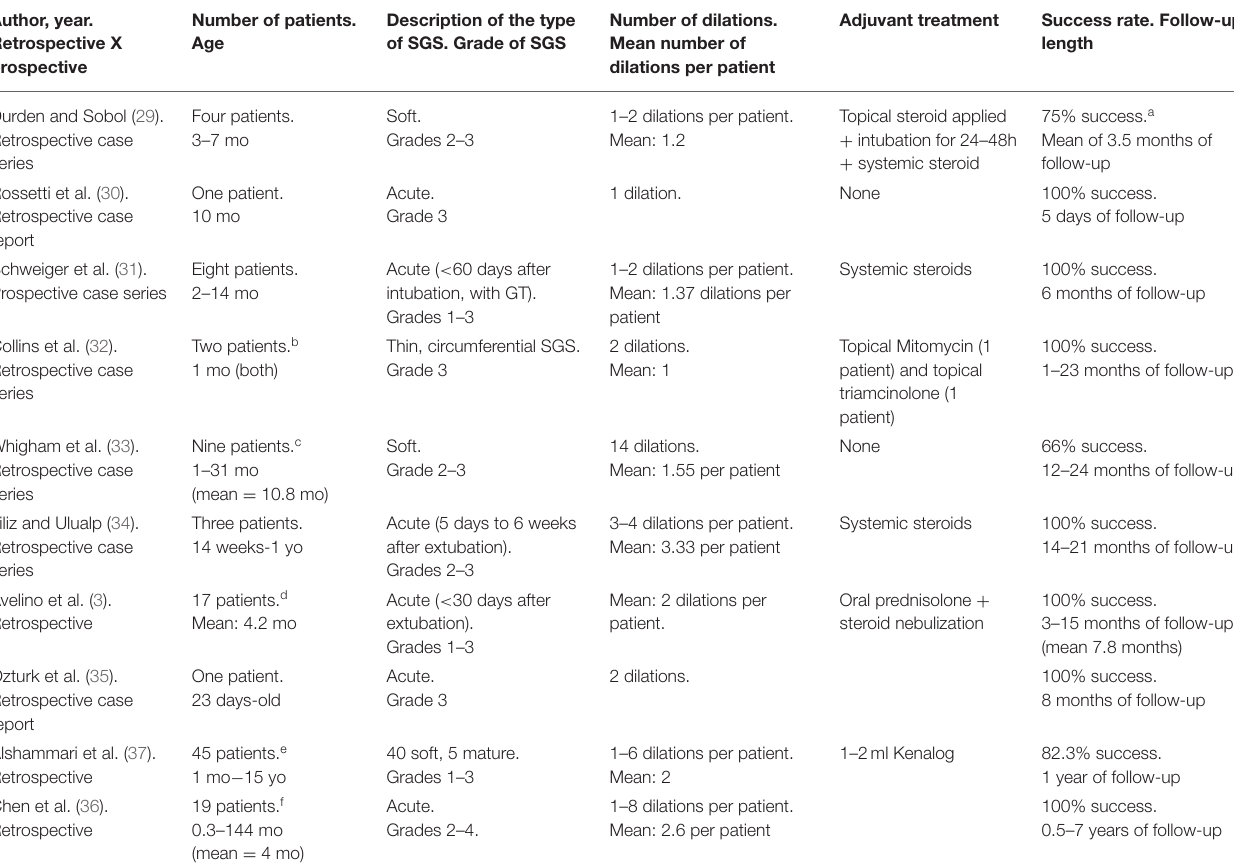
TABLE 3 | Balloon dilation: case reports and case series ( n = 109). Author, year. Retrospective